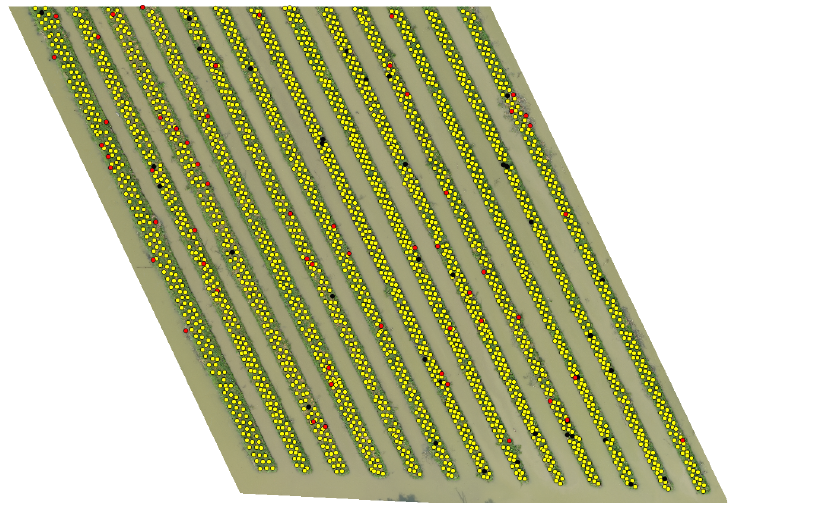
Fig 12. Detection results of combination